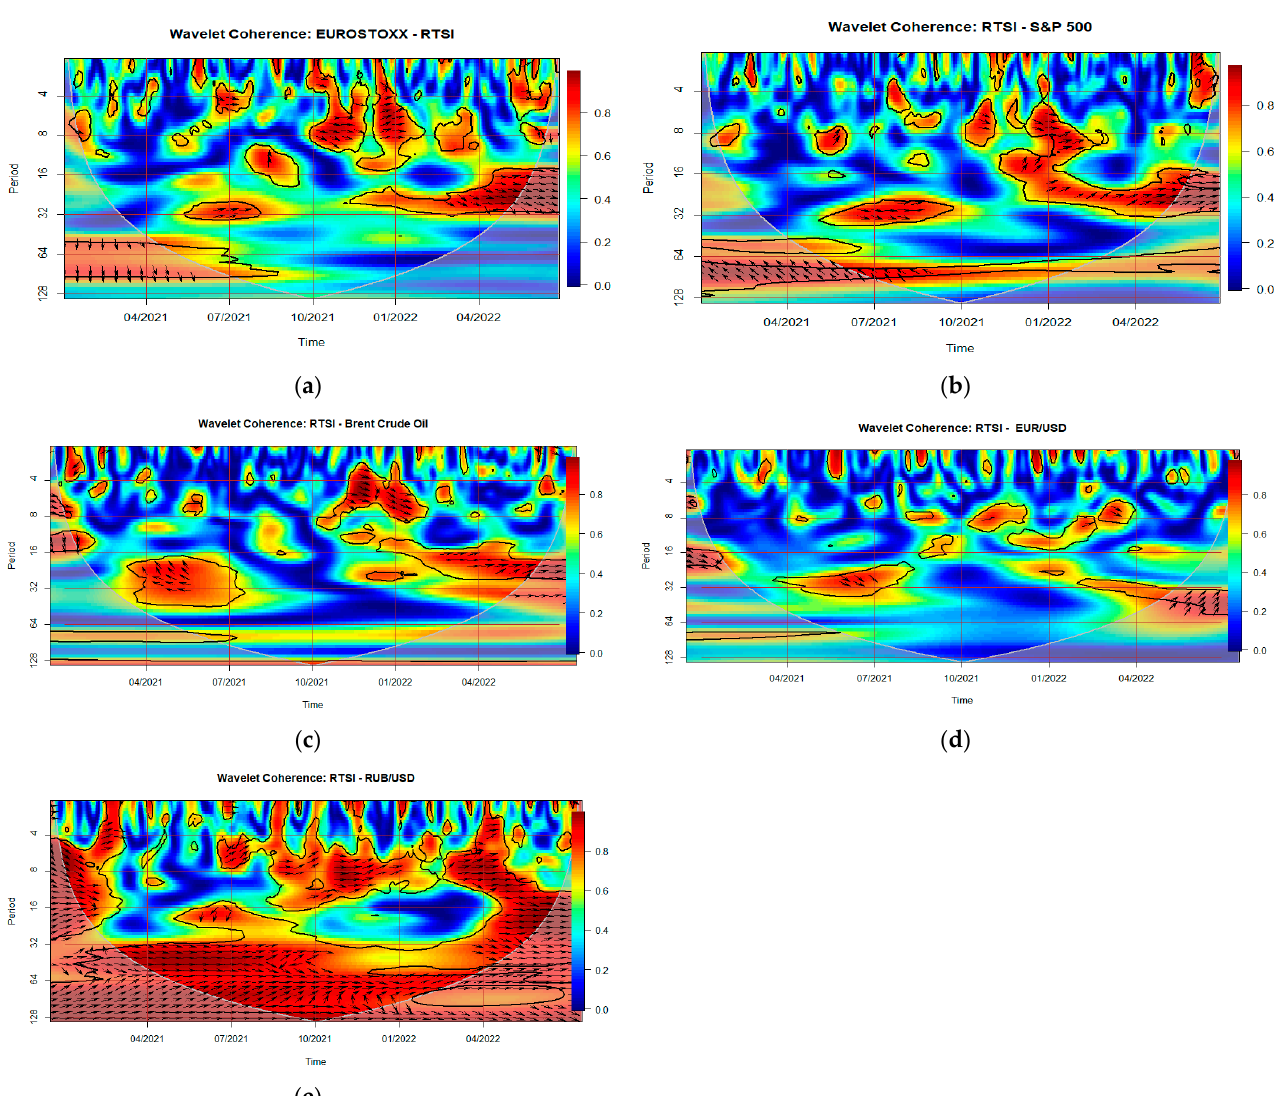
Figure 1. ( a – e ) Wavelet coherence between RTSI and ( a ) Eurostoxx, ( b ) S&P 500, ( c ) Brent crude oil, ( d ) EUR/USD and ( e ) RUB/USD.